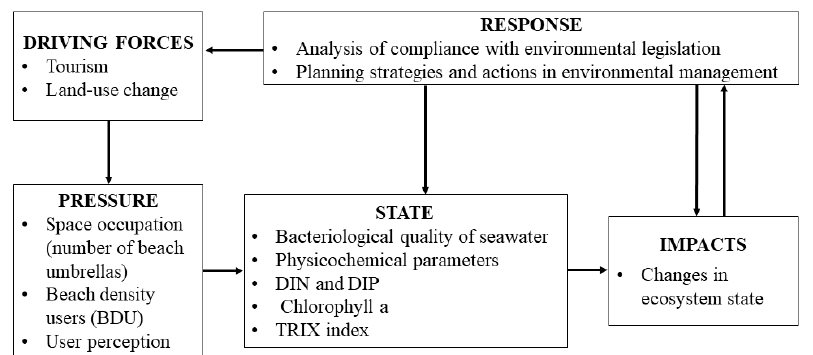
Figure 2. Diagram of the driving forces–pressure–state–impact–response (DPSIR) model structure, showing the indicators used for the La Boquita coastal